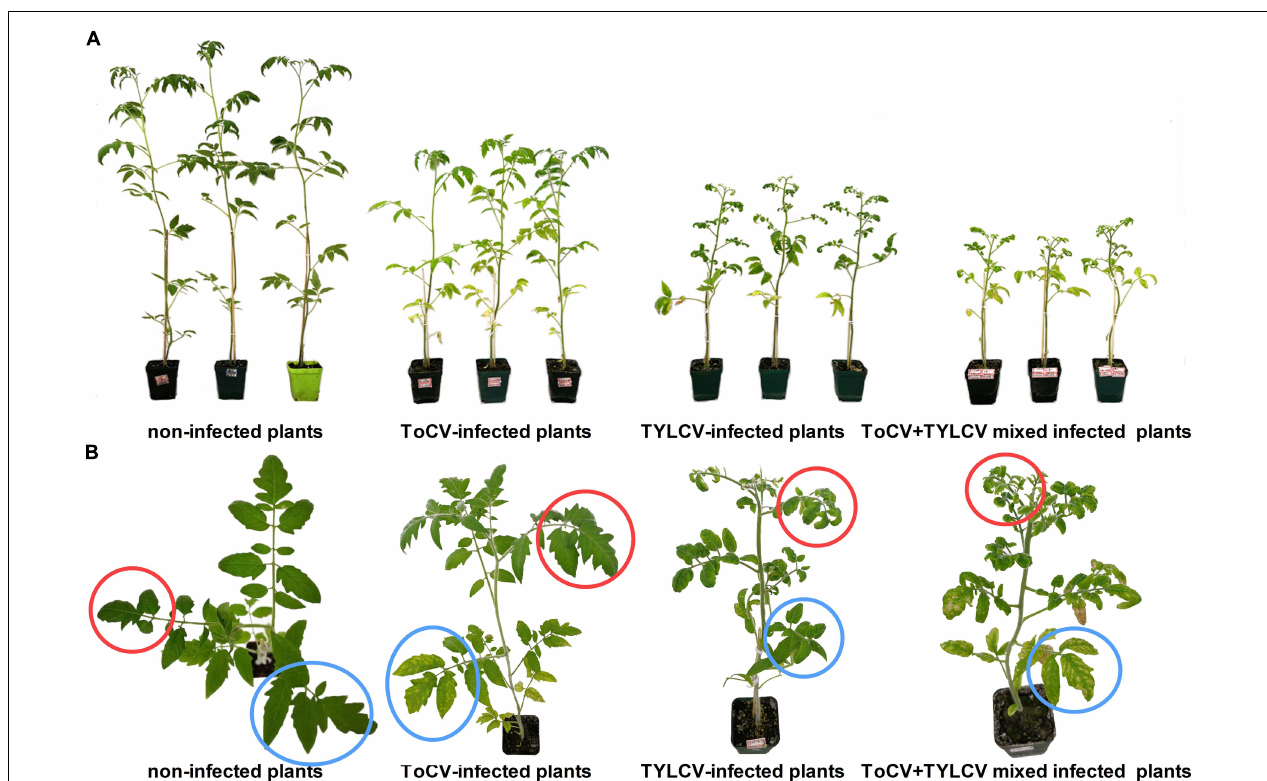
FIGURE 2 | Symptoms of non-infected and virus-infected tomato plants after 42 days post-inoculation. (A) Side view of tomato plants. (B) Zoom of the top view of tomato plants. Red circles, upper leaves; blue circles, lower leaves.